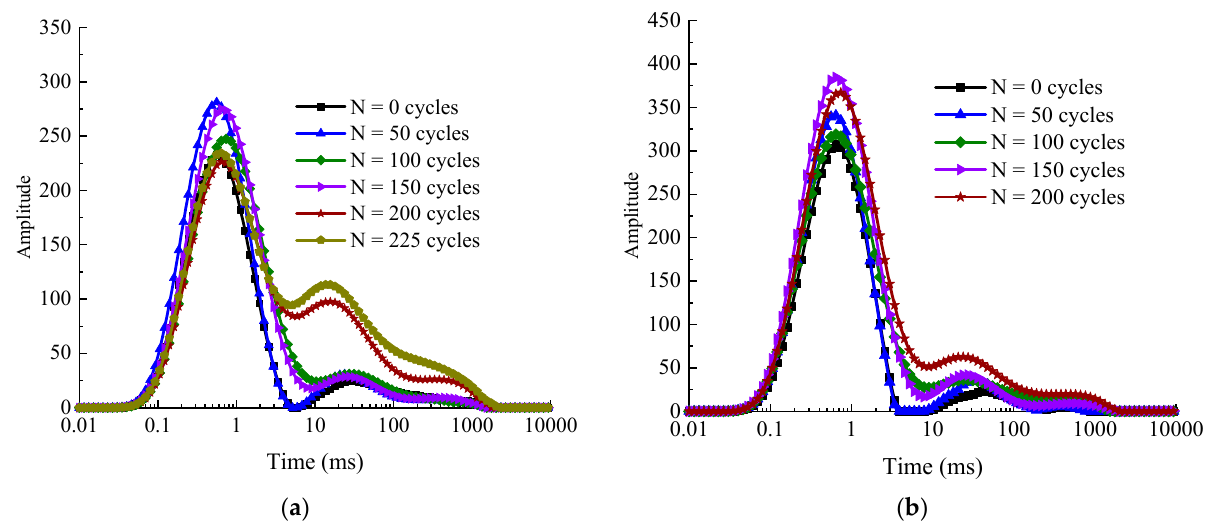
Figure 16. Changes of T 2 distribution curves of concrete samples after different numbers of freeze–thaw cycles. ( a ) w/c = 0.45 and ( b ) w/c = 0.55.